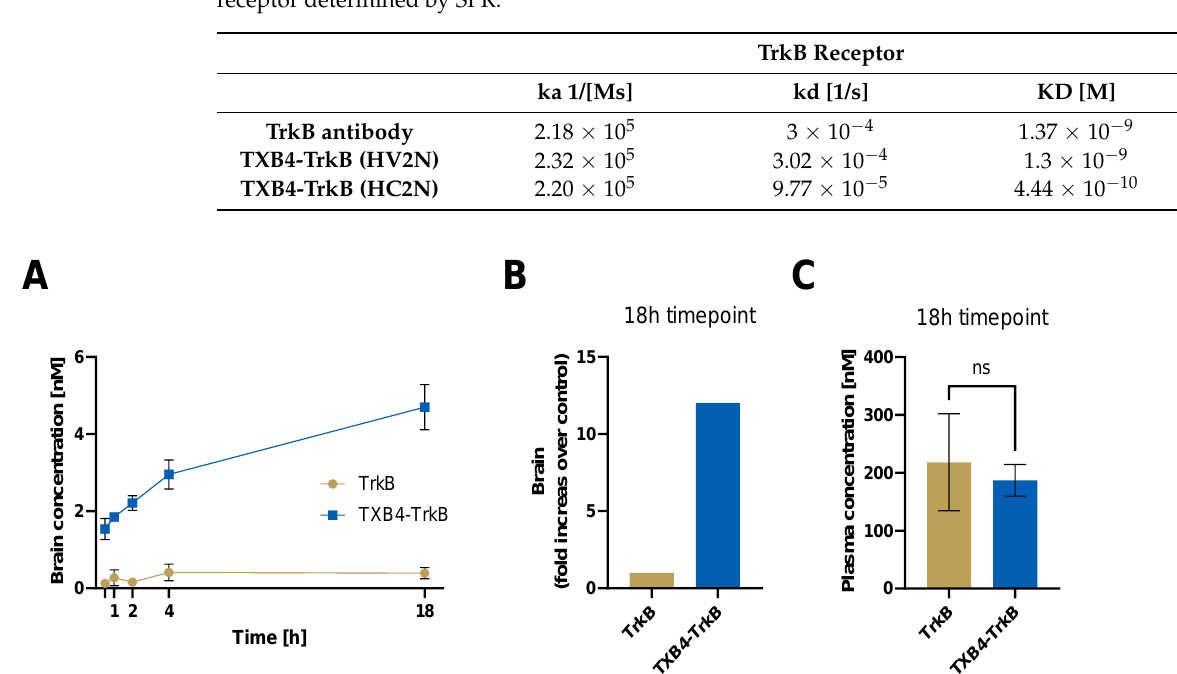
Figure 2. Brain uptake of TrkB antibody and TXB4-TrkB antibody fusion. Equimolar doses of the TrkB antibody (3.6 mg/kg) or TXB4-TrkB fusion in the HV2N format (4.3 mg/kg) were administered by single IV injection. Brains were perfused and harvested, and antibody concentrations were determined at the given timepoints. The brain concentration of the TXB4-TrkB fusion rapidly increases after injection ( A ) with brain levels reaching 12-fold over the control by 18 h ( B ), whereas the difference in plasma levels was not significant (ns) as determined by two-tailed, unpaired t-test ( C ). Data are presented as the mean ± SD, n = 3.